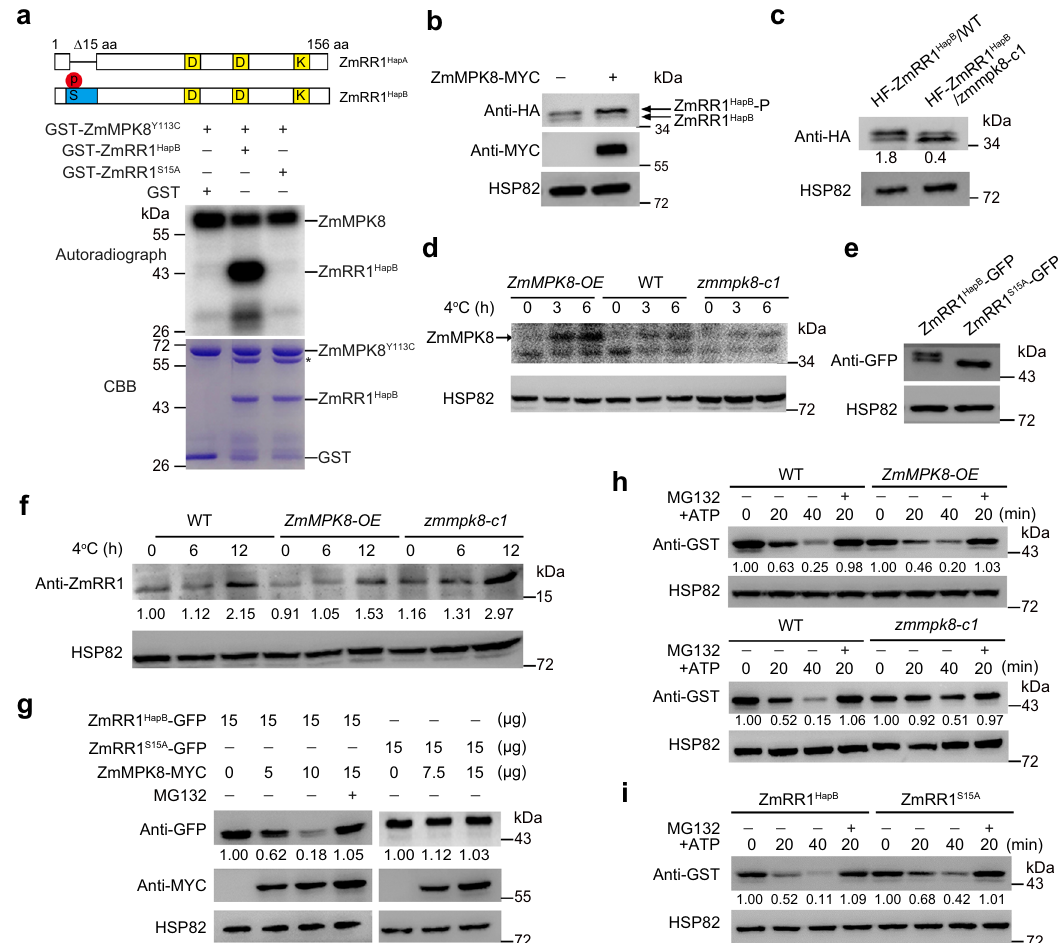
Fig. 4 ZmMPK8 mediates the phosphorylation and degradation of ZmRR1. a ZmMPK8 phosphorylates ZmRR1 HapB in vitro. Diagram shows the phosphorylation site on ZmRR1 HapB (top). Phosphorylated ZmRR1 was detected by autoradiography (middle). Recombinant proteins were detected by Coomassie brilliant blue (CBB) staining (bottom). Asterisk represents nonspeci fi c bands. b Immunoblot analysis of HF-ZmRR1 HapB co-expressed with or without ZmMPK8-MYC in N. benthamiana leaves. c Immunoblot analysis of HF-ZmRR1 HapB expressed in maize protoplasts isolated from wild type or zmmpk8-c1 . The relative ratio between phosphorylated and unphosphorylated protein was determined using ImageJ software. d In-gel kinase assay of ZmMPK8 using total protein extracts from the wild type, ZmMPK8-OE , and zmmpk8 plants using GST-ZmRR1 as substrate. ZmMPK8 kinase activity was detected by autoradiography. HSP82 was used as a control. e ZmRR1 HapB -GFP and ZmRR1 S15A -GFP proteins expressed in maize protoplasts. ZmRR1 was detected with anti-GFP antibody. f Immunoblot analysis of ZmRR1 HapB protein levels in the wild type, ZmMPK8-OE , and zmmpk8-c1 plants under cold stress. Ten-day-old seedlings were incubated at 4 °C for the indicated time. ZmRR1 was detected with anti-ZmRR1 antibody. g Immunoblot analysis